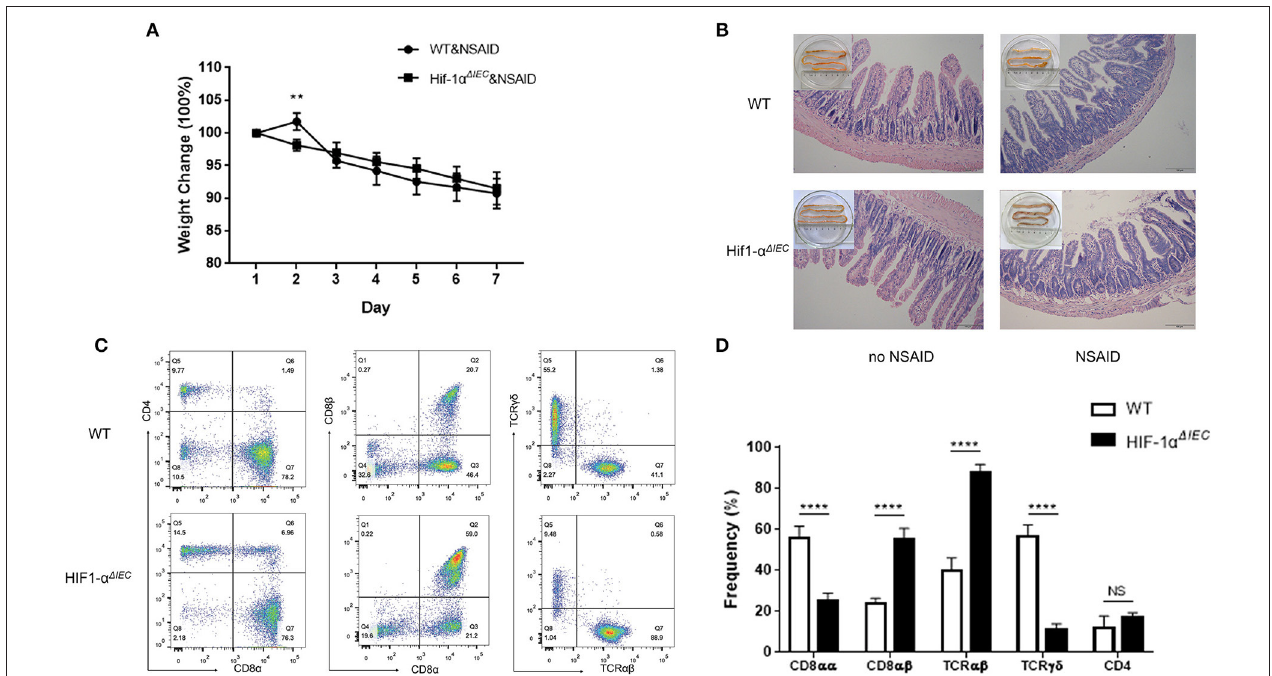
FIGURE 5 | Hif-1 α deficiency in epithelial markedly changed the population of IELs in NSAID-induced small intestinal injury. Damages were assessed in indomethacin-treated WT and Hif1- α ∆ IEC mice by (A) weight loss, (B) histological analysis, (C,D) the proportionality of the indicated IEL subsets in indomethacin-induced enteropathy ( n = 5–7 mice/group). Images are 200x. ** P < 0.01; **** P < 0.0001; NS, not significant.